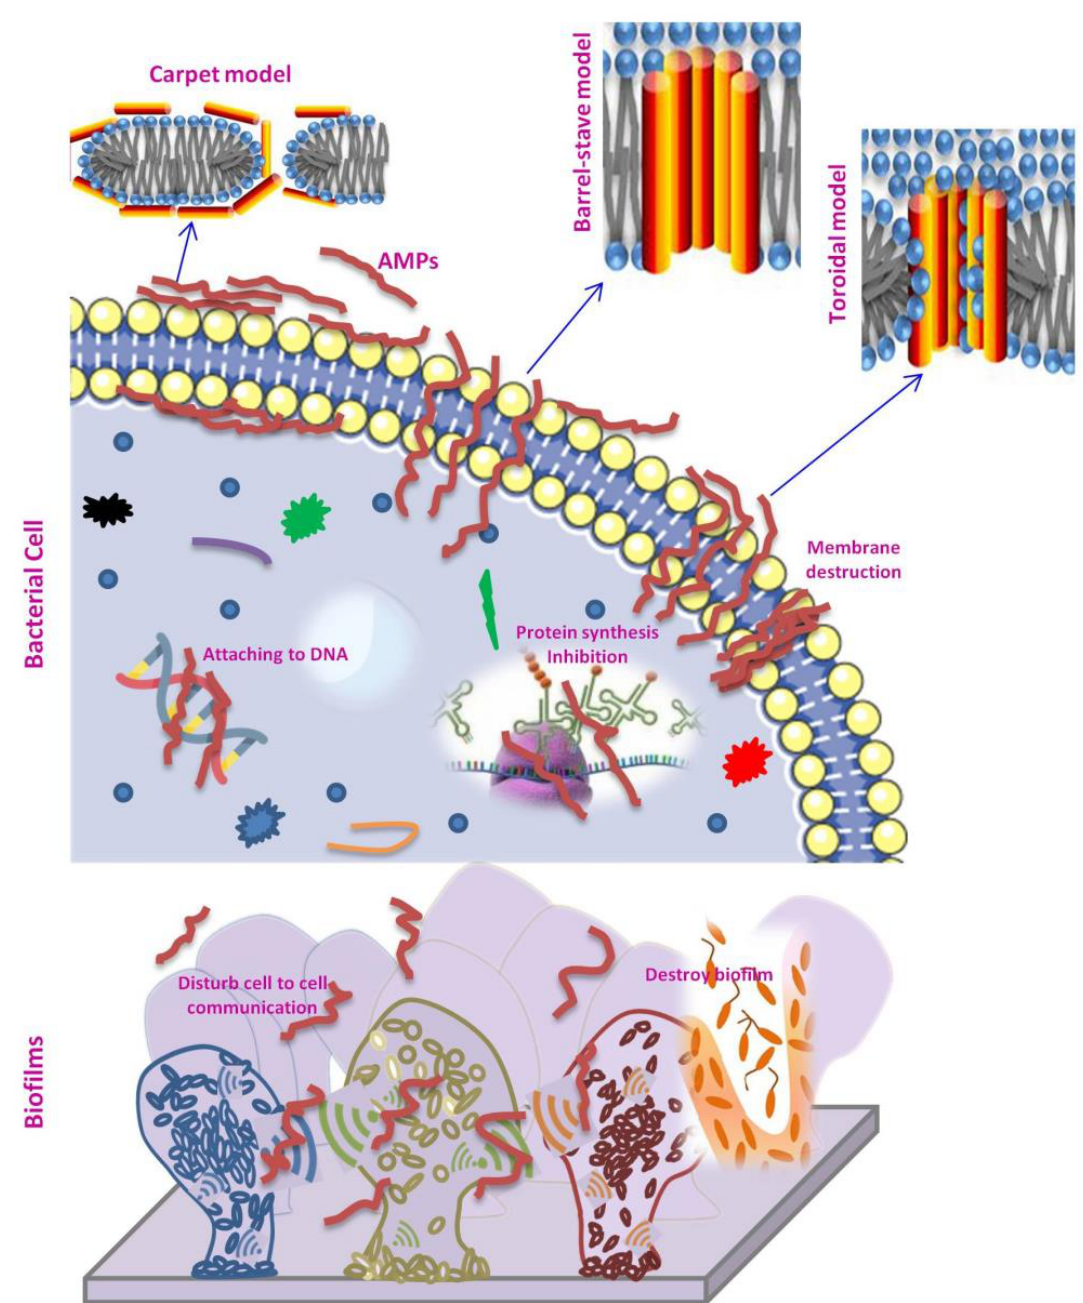
Figure 1. Mode of action of F-AMPs against bacterial cells and biofilms.